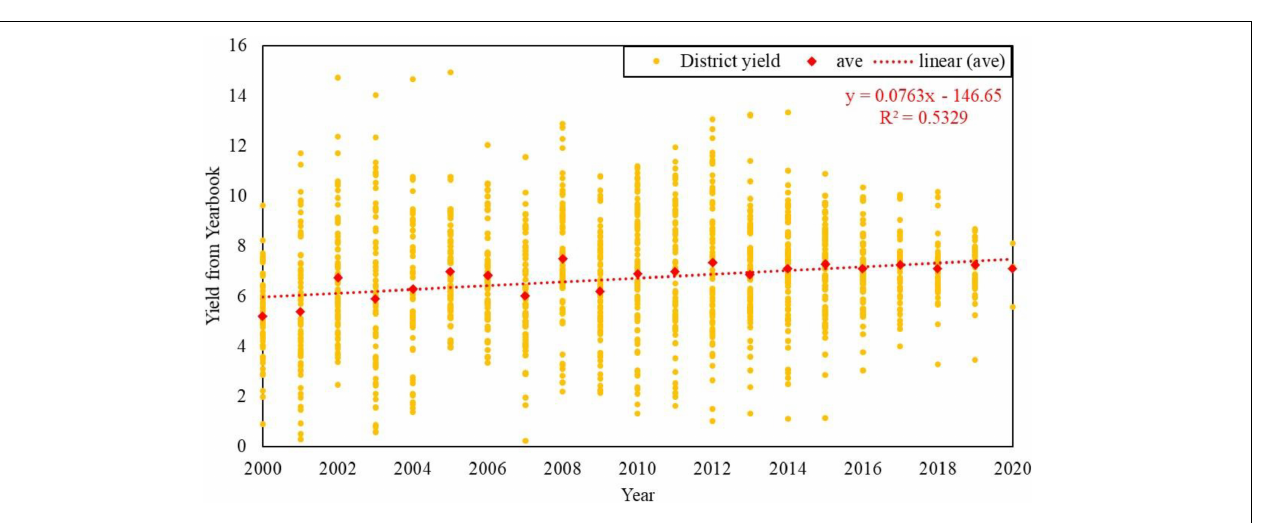
and those at the lower part of the canopy began to turn